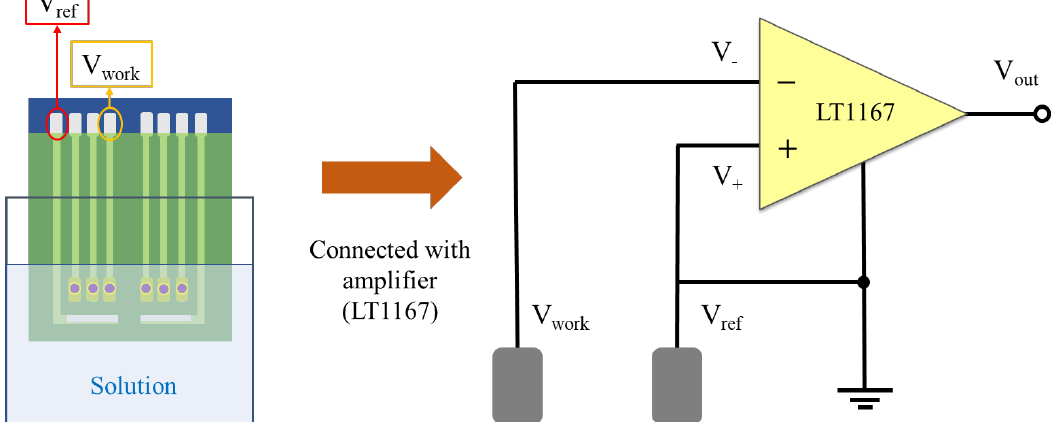
Figure 3. Working schematics of the potentiometric measurement, which utilizes the voltage difference between a working electrode and a reference electrode to perform. LT1167 is the amplifier used in the readout circuit (inset).